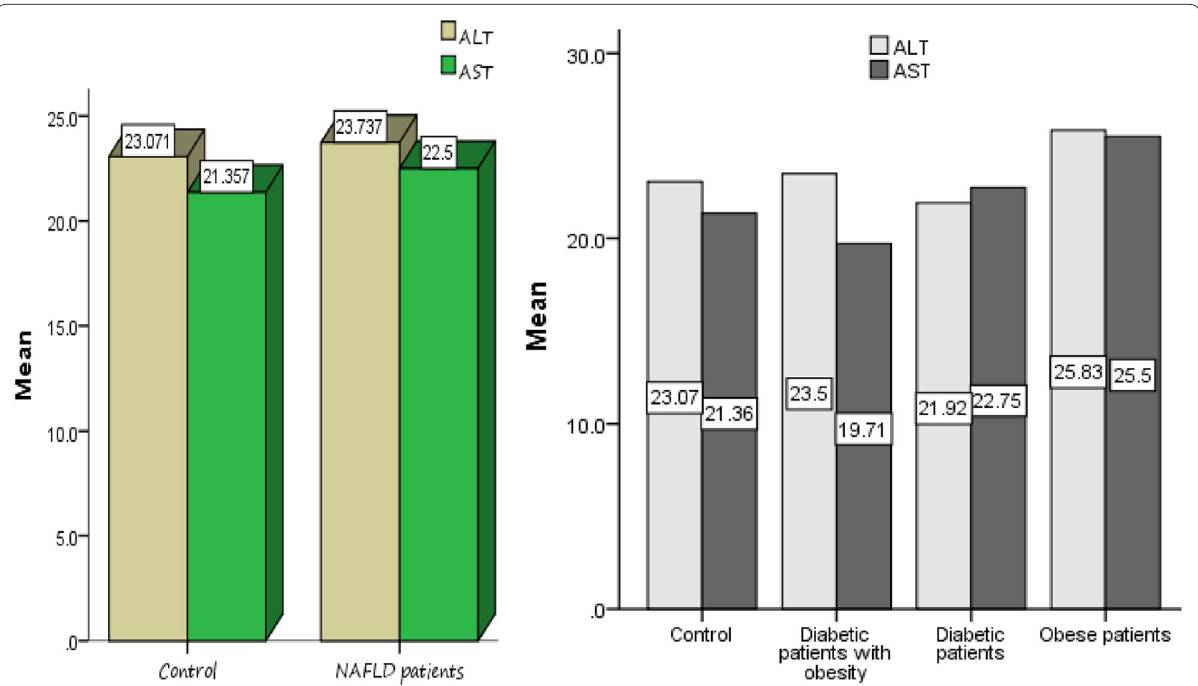
Fig. 1 Comparison between ALT and AST levels in all studied